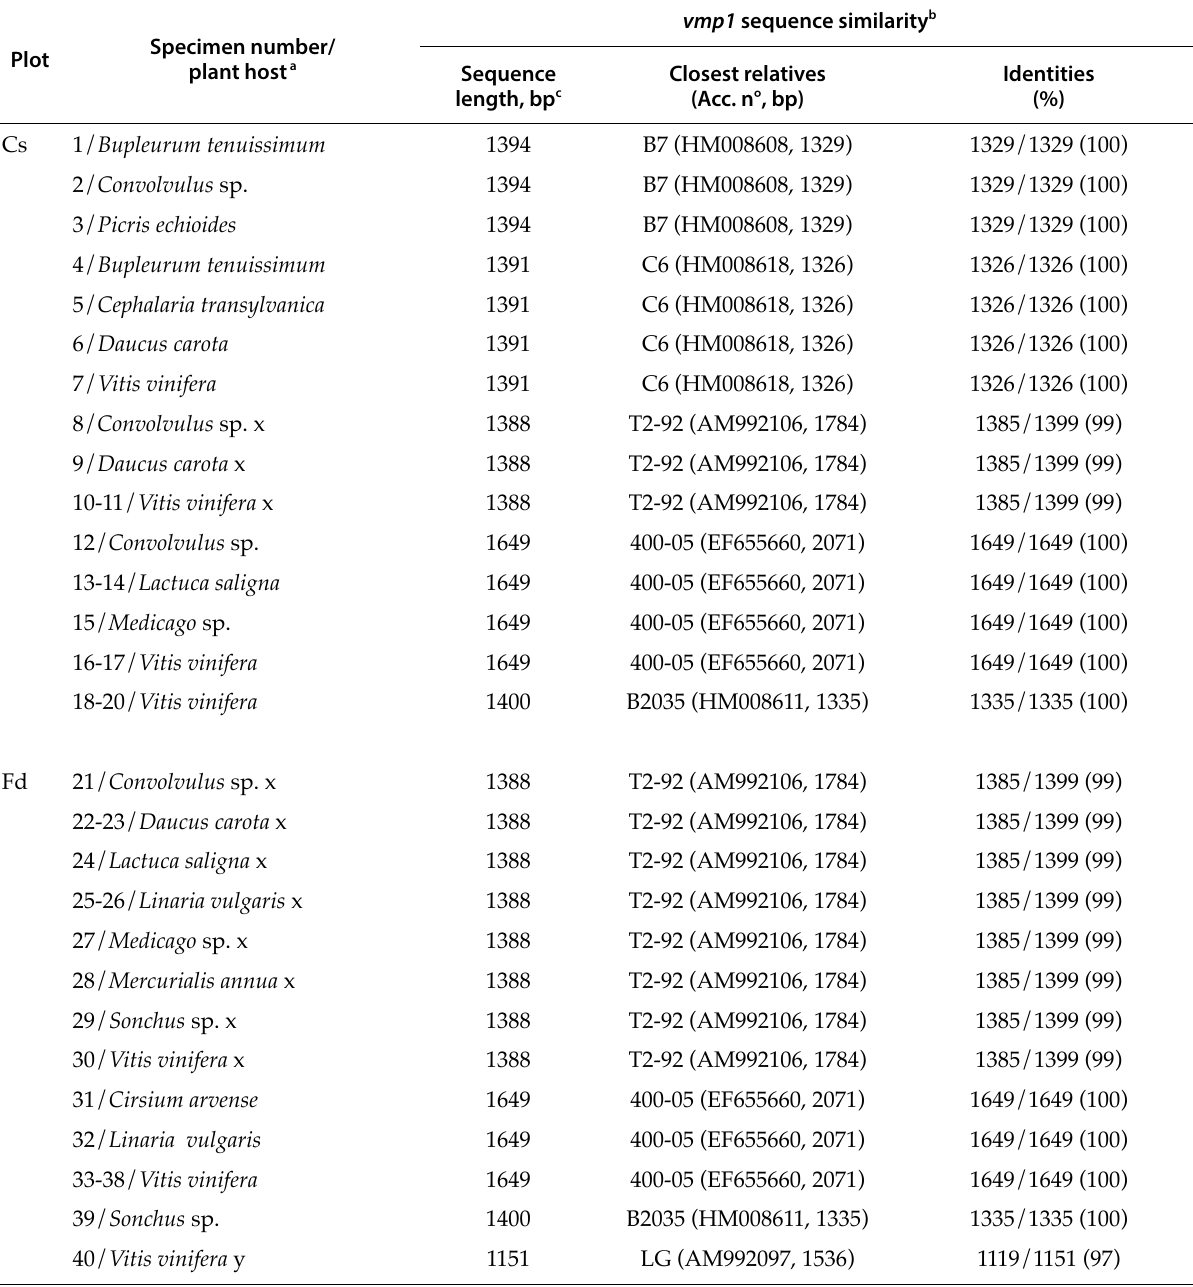
Table 2. Characterization of the ‘ Ca . P. solani’ population found in the different plant hosts growing in vineyards Cs and Fd in October 2010, according to vmp1 gene sequence